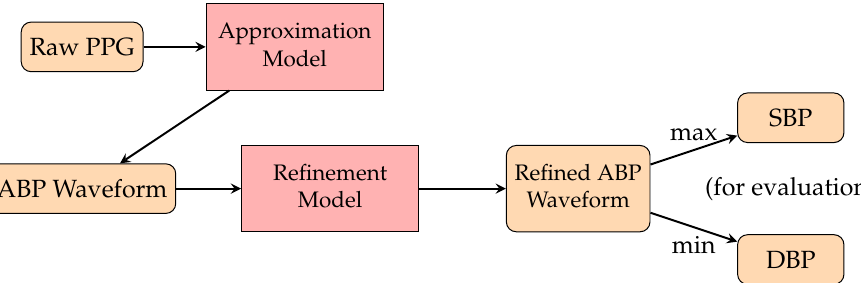
Figure 11. The structure of the algorithm in [141]. PPG signals are preprocessed by the wavelet transform with the removal of the very low and very high frequency components, the soft Rigrsure thresholding [198,199], and the normalization. The filtered PPG signals are processed through the approximation network (one-dimensional deep supervised U-net model), which estimates the ABP based on the inputs, and then refined by the refinement network. The maximum and minimum of the refined ABP signals are taken as SBP and DBP,